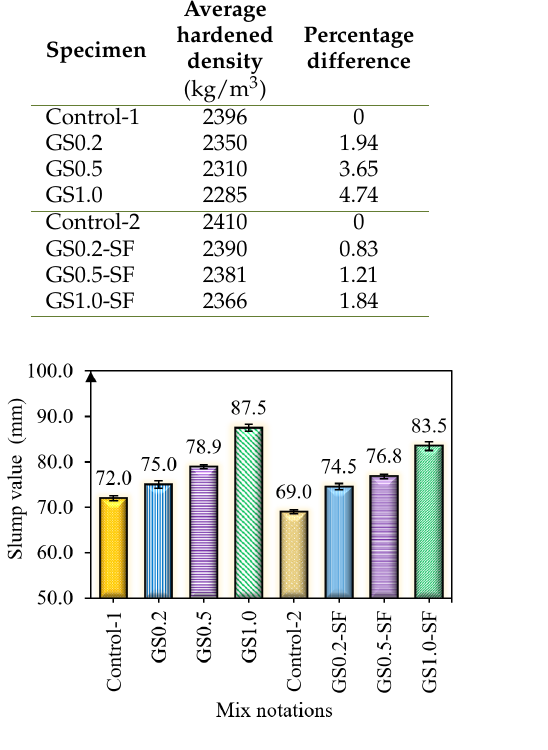
Fig. 3. Slump values of CRT concrete